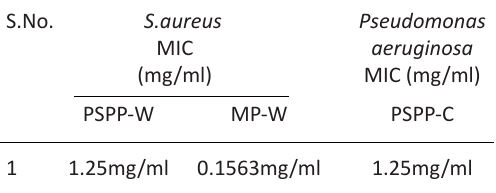
Table 6. MIC for plant extracts with Antibacterial activity S.No .